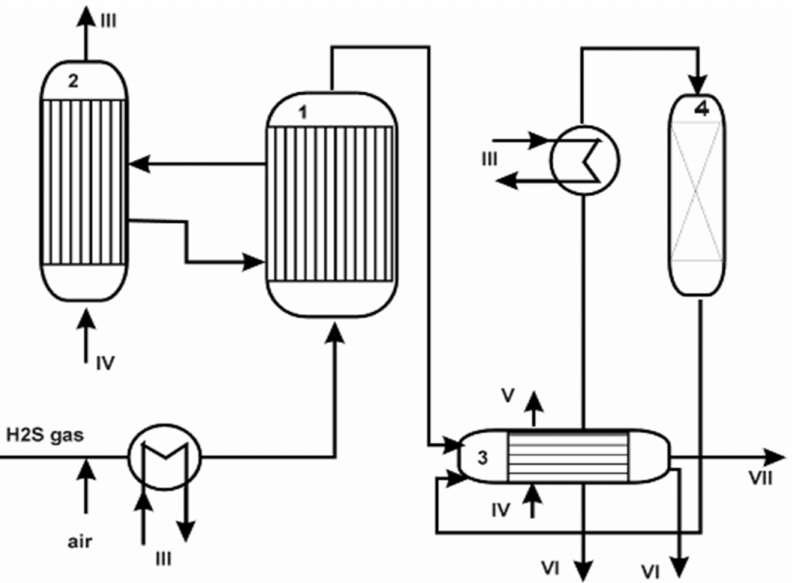
Figure 8. Schematic of Catasulf ® process Catasulf ® , perhaps, the only “active” large-capacity tech- nology to obtain sulfur based on the reaction of the direct oxidation of hydrogen sulfide (adapted from